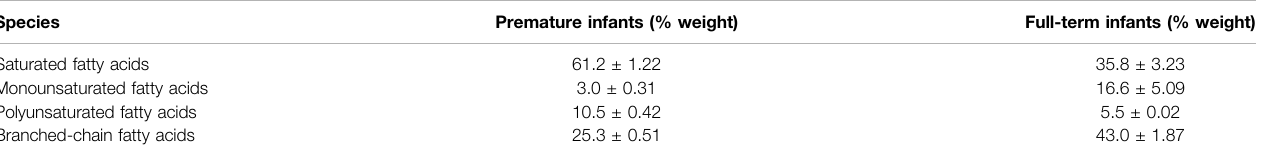
TABLE 1 | Pro fi le of the fatty acid classes in vernix caseosa from premature and full-term infants (Li et al., 2021). Species Premature infants (% weight) Full-term infants (% weight) Saturated fatty